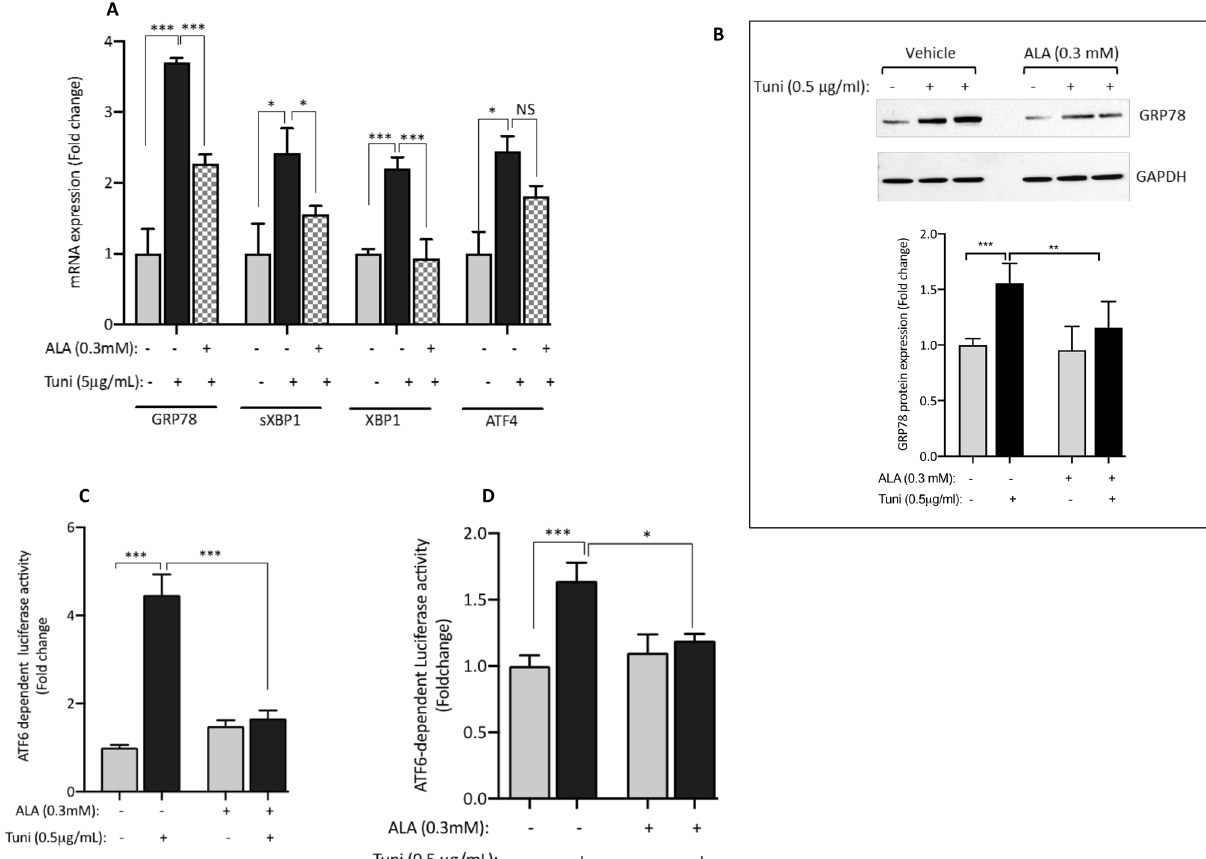
Figure 2. ALA alleviates tunicamycin-induced ER stress. ( A , B ) Pre-treatment of C2C12 cells with 0.3 mM ALA abolishes significantly the mRNA expression of classical ER stress markers in response to tunicamycin treatment ( A ). ( B ) Western blot confirming the effect of ALA on tunicamycin-induced expression of GRP78 protein. Full-length blots are displayed in Supplementary Fig. S2. ALA also reduces ATF6-dependent luciferase activity in response to tunicamycin using a functional luciferase-based assay both in C2C12 ( C ) and HepG2 ( D ) cells. Ethanol and DMSO were used at 0.25% as vehicles for ALA and tunicamycin, respectively. After performing Shapiro–Wilk normality test, one way ANOVA was used to compare the effect of treatments. NS not significant; *P < 0.05; **P < 0.01; ***P <